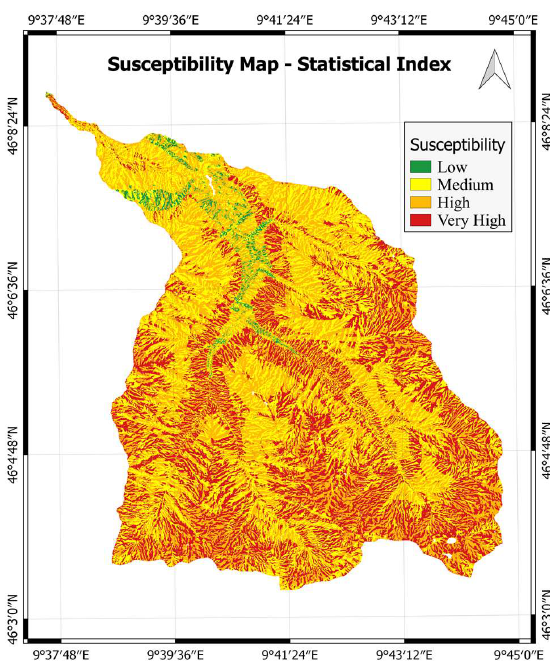
Figure 3. Susceptibility map produced with Statistical Index